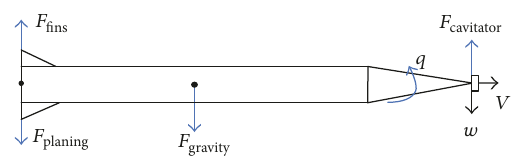
Figure 2: Structure and forces of supercavitating